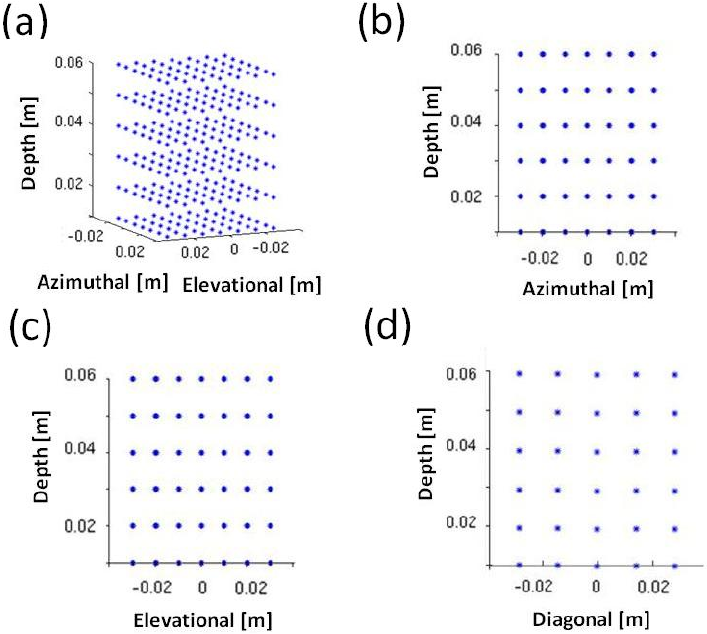
Figure 2. Graphical illustration of 3-D phantom in ( a ) 3-D coordinate, ( b ) azimuthal ( x - z ), ( c ) elevational ( y - z ), and ( d ) diagonal ( xy - z ) planes.